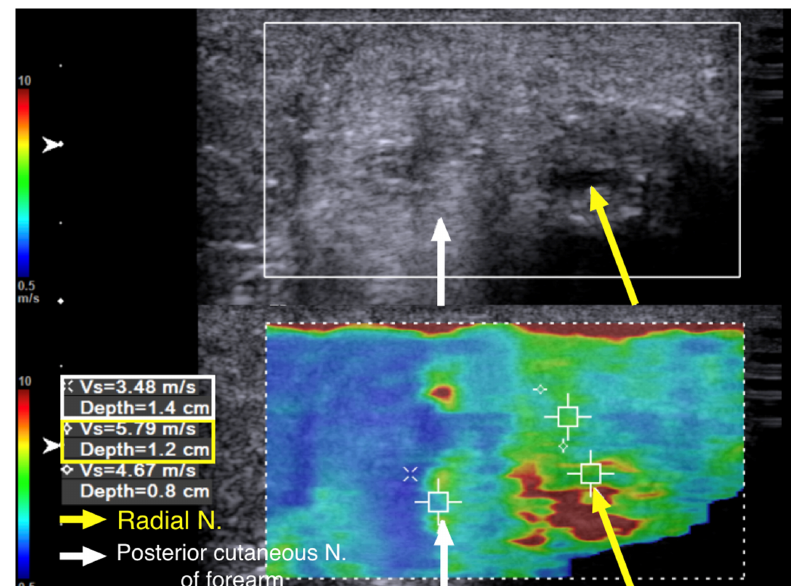
Figure 6. Case 2: Shear wave velocity at the exit of the spiral groove. A 43-year-old man with radial nerve palsy after plating of a left humeral shaft fracture. Ultrasound images with cross-sectional view of the radial nerve after its exit from the spiral groove. The radial nerve and the posterior cutaneous nerve of the forearm were swollen. The shear wave velocity of the radial nerve was 5.79 m / s (yellow arrow and box), and that of the posterior cutaneous nerve of the forearm was 3.48 m / s (white arrow and box).